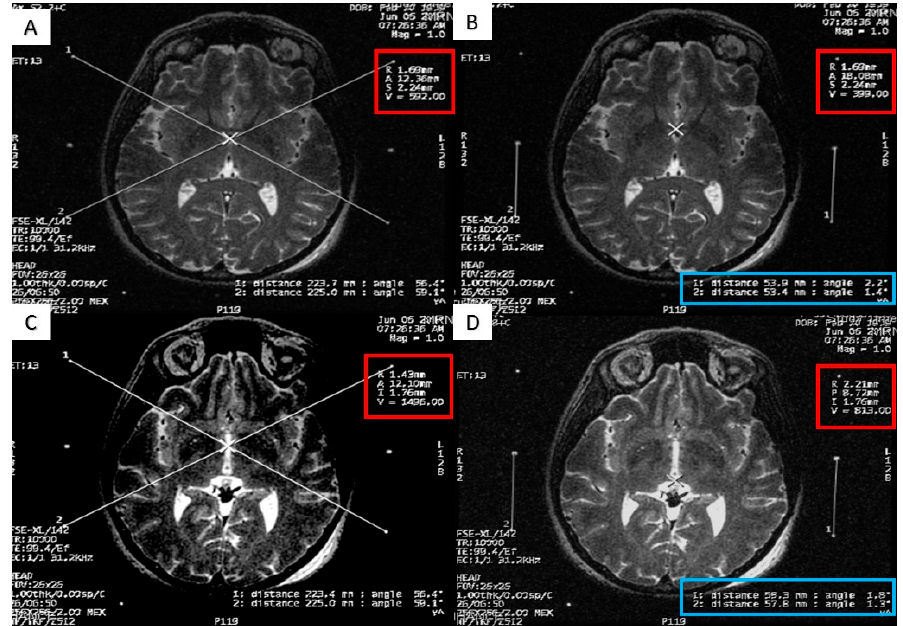
Figure 4. Calculating the anterior commissure (AC) and posterior commissure (PC) coordinates using the magnetic resonance console. ( A ) Two diagonal lines intersecting at the center of the frame at the AC level with the magnetic resonance imaging (MRI) coordinates of the center of the frame shown inside the red square; ( B ) a crosshair at the posterior margin of the AC, with the MRI coordinates of the AC shown inside the red square. Two lines are drawn between the middle and the lower fiducials on both sides of the frame and their lengths (in the blue rectangle) are used to calculate the Z coordinate of the AC. ( C ) Two diagonal lines intersecting at the center of the frame at the PC level with the MRI coordinates of the center of the frame shown inside the red square; ( D ) a crosshair at the anterior margin of the PC, with the MRI coordinates of the PC shown inside the red square. Two lines are drawn between the middle and the lower fiducials on both sides of the frame and their lengths (in the blue rectangle) are used to calculate the Z coordinates of the PC.